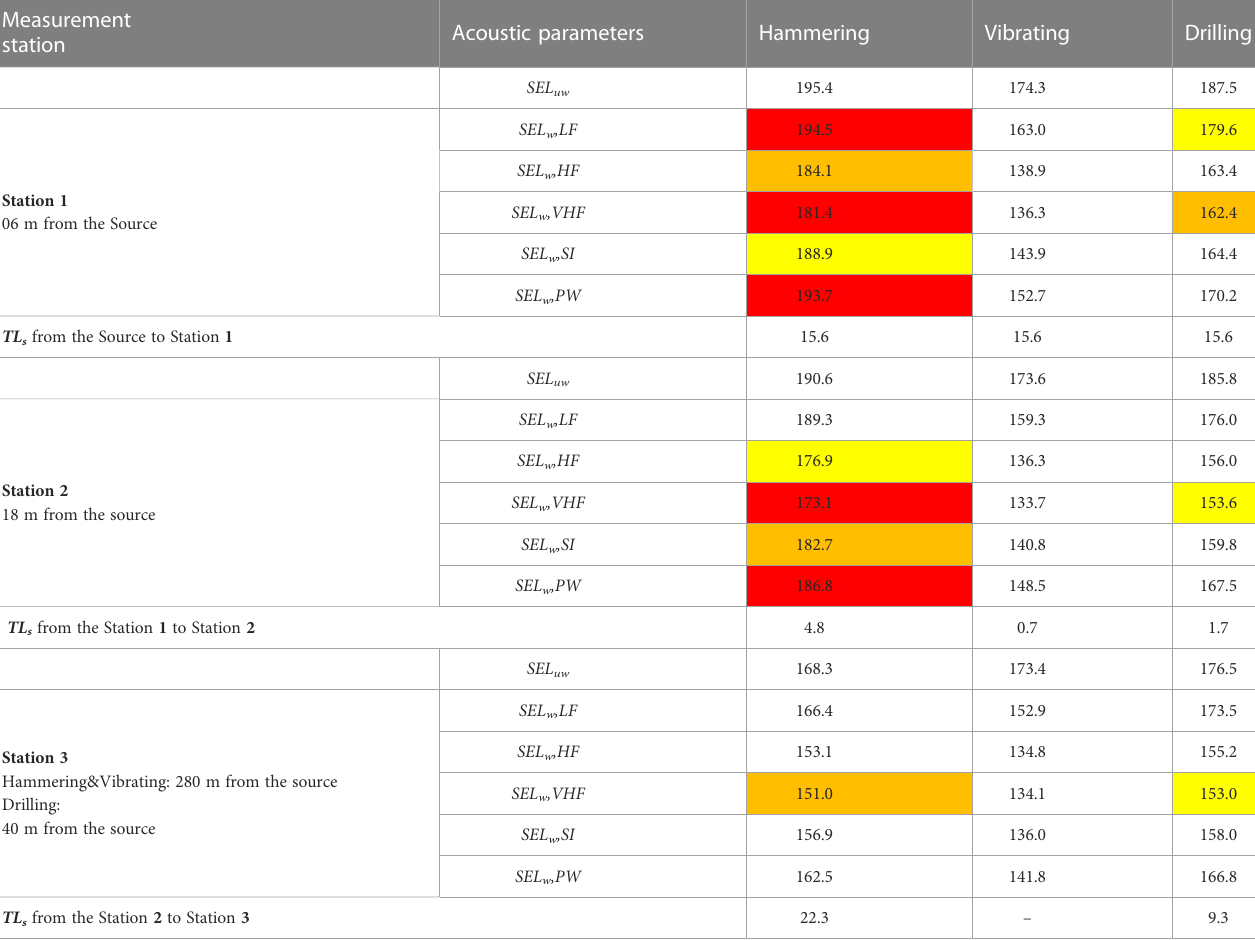
TABLE 2 The SEL w of hammering noise, vibrating noise, and drilling noise that measured at the three stations during OED. Measurement